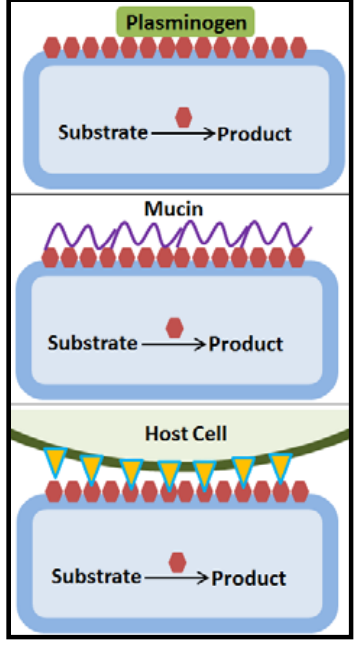
Figure 5. Moonlighting proteins (red hexagonals) have multiple functions, the main function for example being as housekeeping enzymes in the intracellular metabolism. The secretion mechanism to the cell surface where moonlighting proteins can act with roles in adhesion to proteins of the extracellular matrix or plasminogen, glycoproteins of the mucin layer or host cell surface proteins has not been elucidated